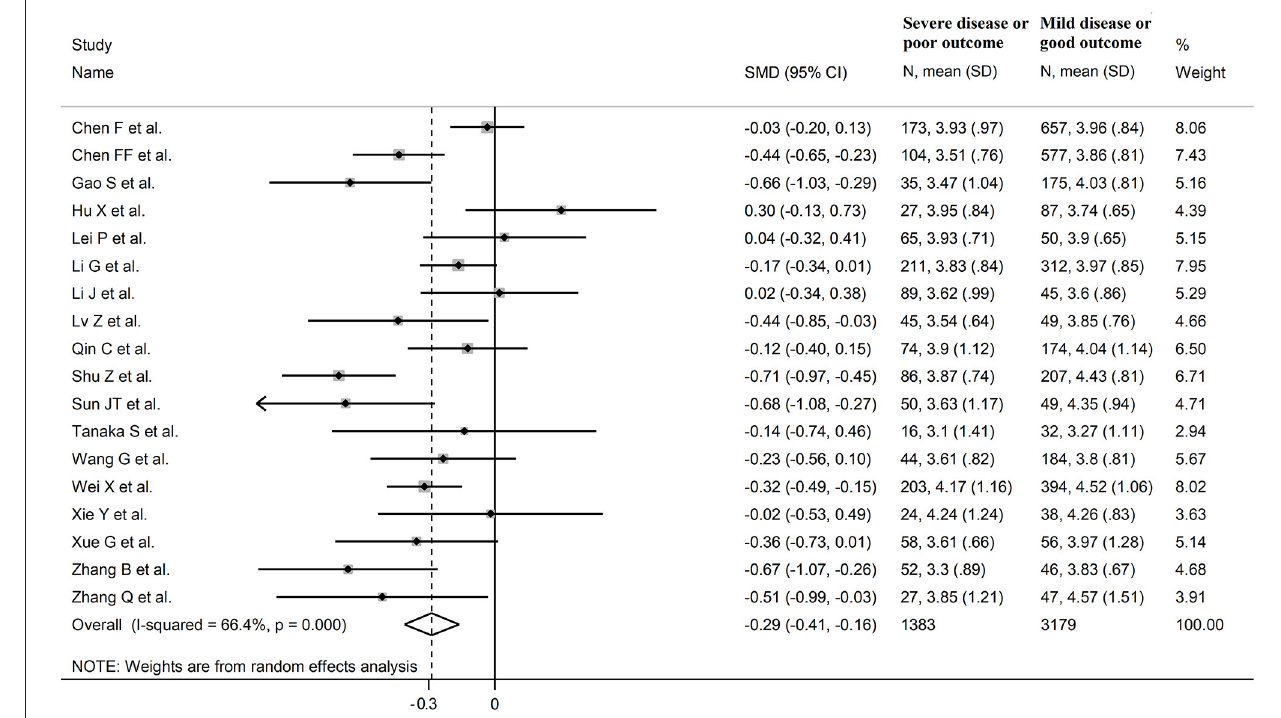
( t = − 1.94, p = 0.07), albumin ( t = − 2.31, p = 0.05), and creatinine